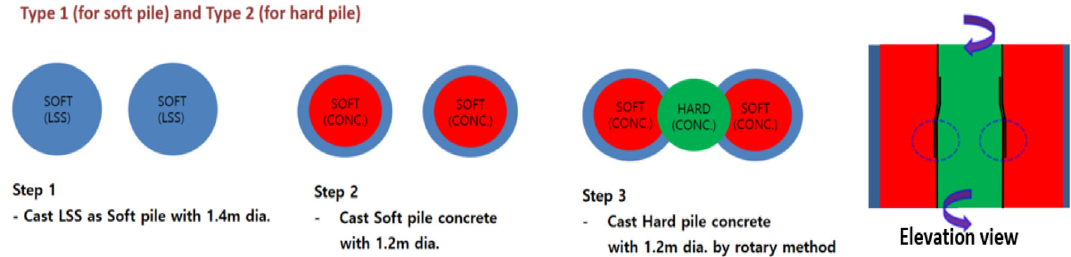
Fig. 8 Method for construction of type 1 and 2 SBPs (plan and